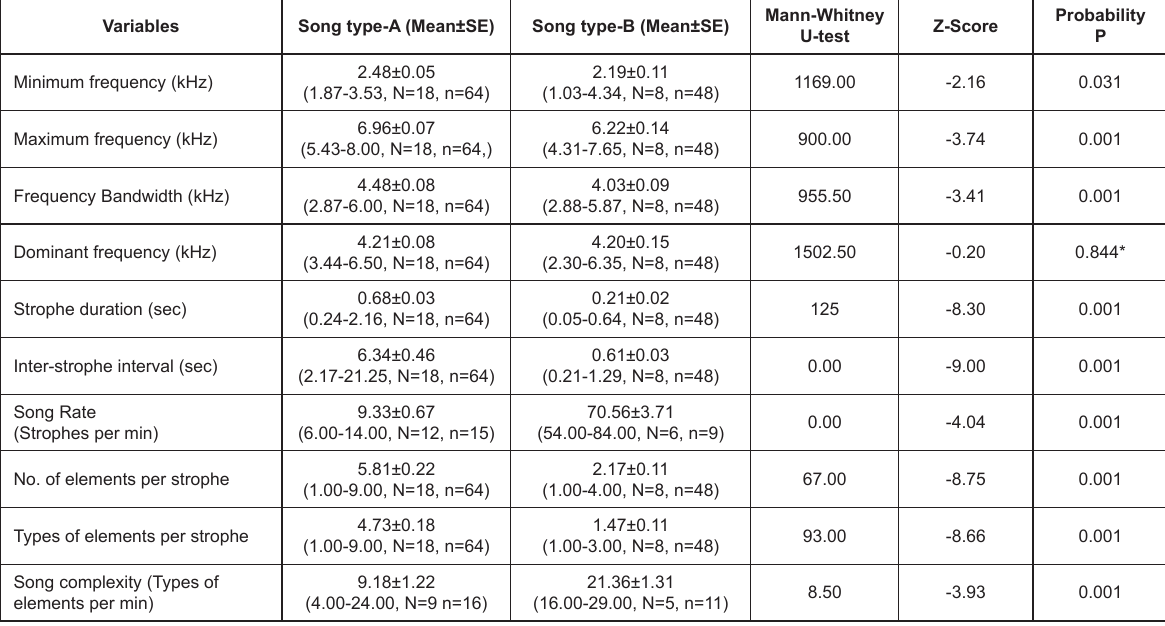
* Not significant; Ranges are given in parenthesis with number of individuals (N) and number of song/strophe samples (n).